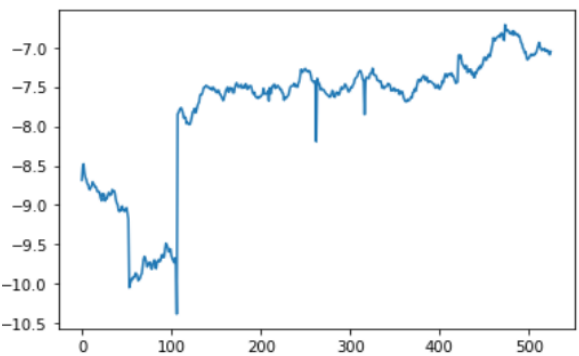
Figure 63. Merged orientation data ( x -axis).